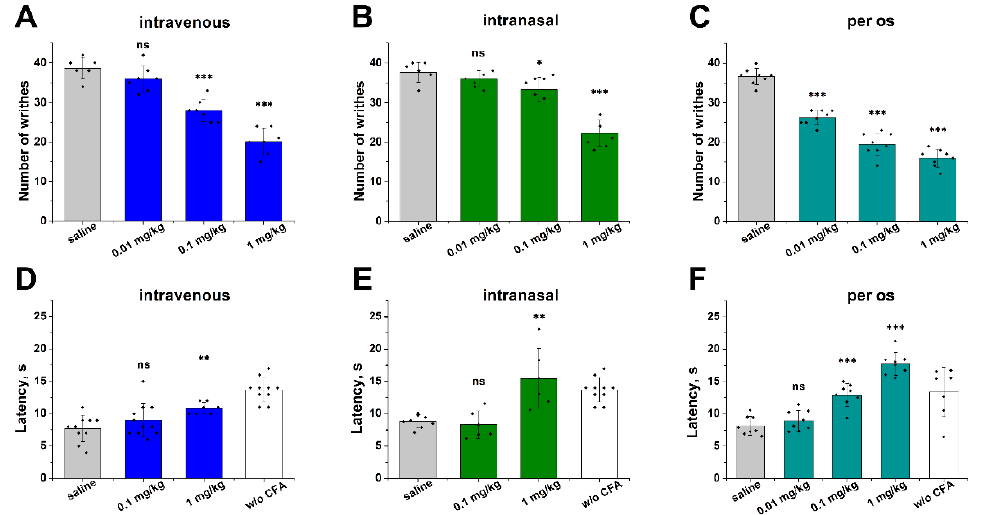
Figure 5. The analgesic and anti-inflammatory effects of sevanol following intravenous, intranasal and per os administration. The effect of sevanol on the acetic acid induced writhing ( A – C ) and on the mice withdrawal latency on a hot plate in the thermal hyperalgesia test after CFA injection ( D – F ) upon intravenous ( A , D ), intranasal ( B , E ) and oral ( C , F ) administration. Pretreating the mice with sevanol (30 min before testing) attenuated the response to the intraperitoneal administration of acetic acid, as estimated by the number of writhes in 30 min intervals, and significantly reversed CFA-induced thermal hyperalgesia prolonging the withdrawal latency for an inflamed hind paw placed on a hot plate. The results are presented as the mean ± SD ( n = 6–10). The p -values of the sevanol groups vs. the saline group are based on an analysis of variance and on Tukey’s test; * p < 0.05, ** p < 0.005, *** p < 0.001.